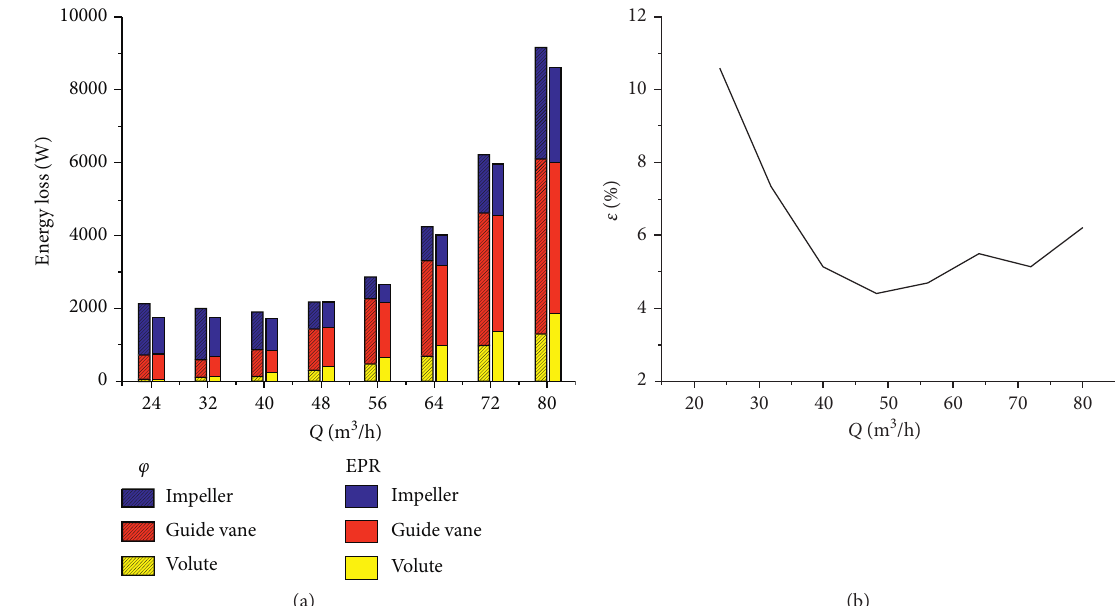
Figure 5: Comparison between loss calculated using the methods of entropy production and pressure difference. (a) Comparison of the two methods for calculating energy loss. (b) Error.